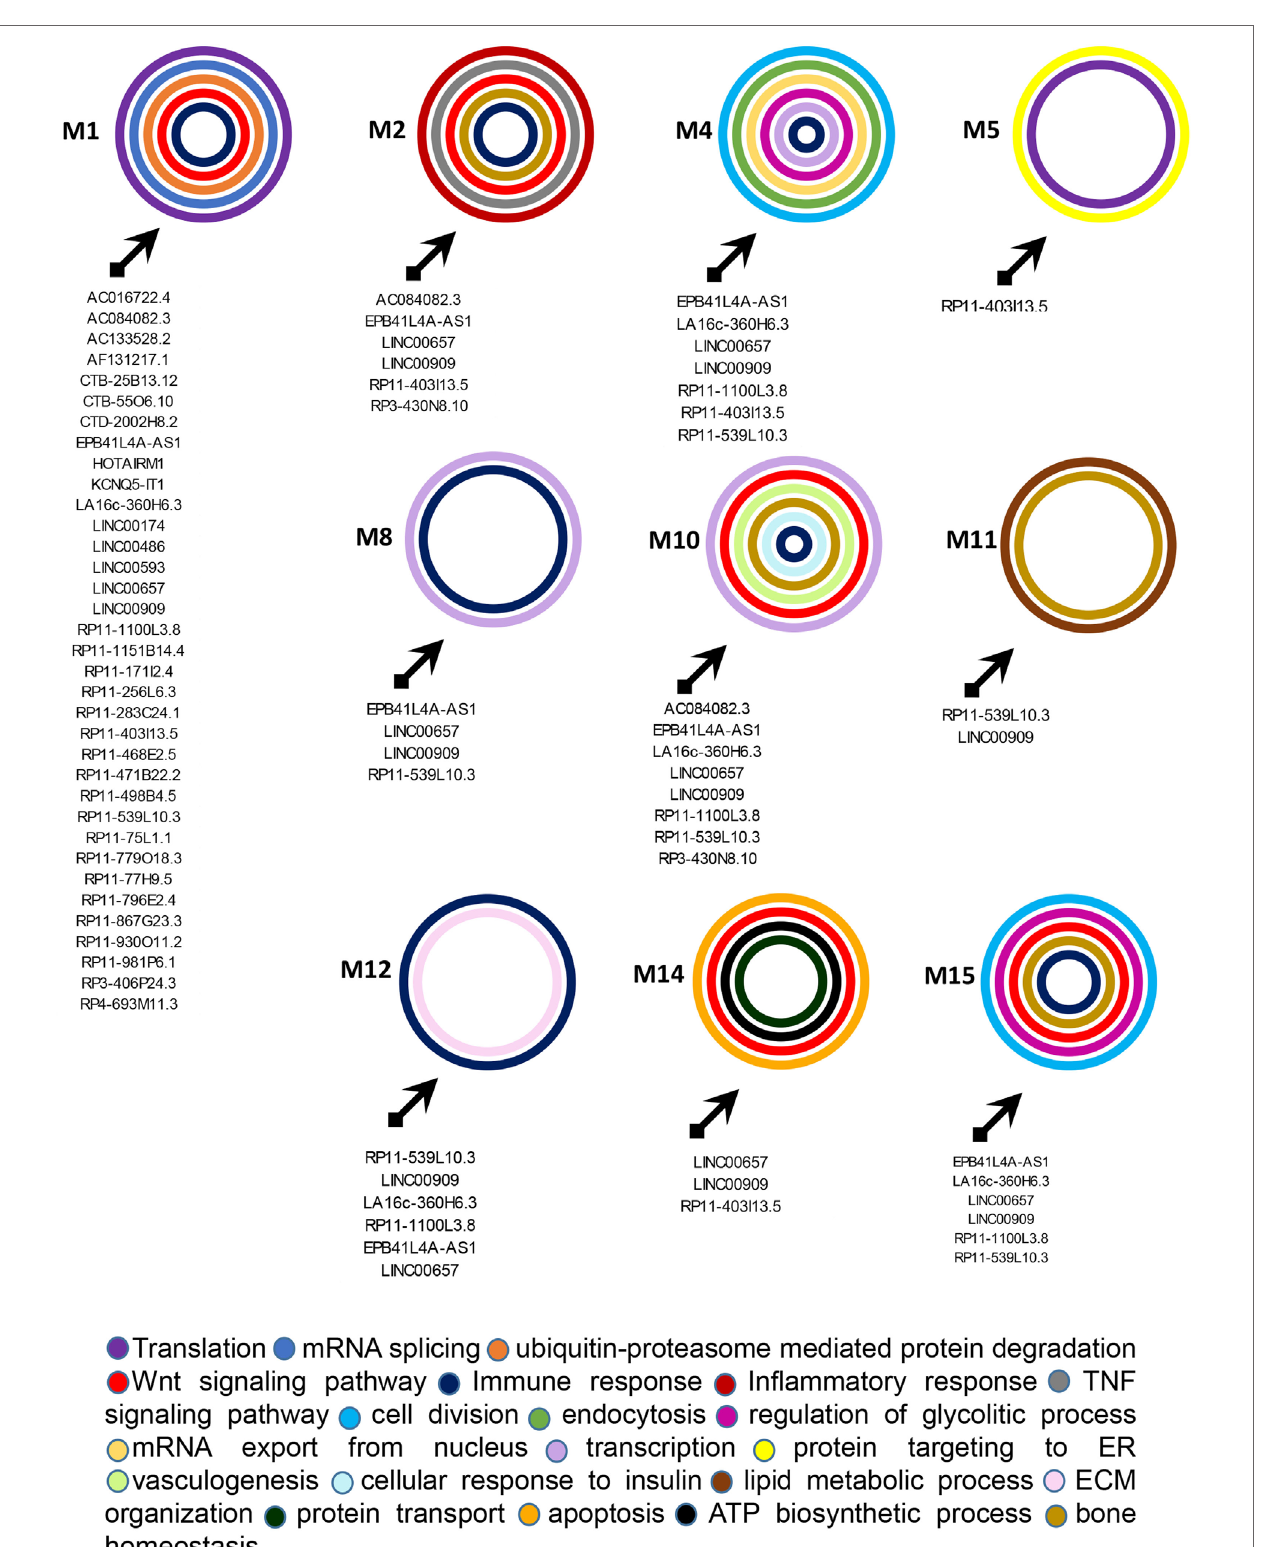
FigUre 5 | Functional classification of genes included in the targeted modules. Graphical representation of long non-coding RNAs targeting the gene modules and of the most relevant biological processes (BPs) in which genes in each module can be classified. The BPs are represented by colored circles (each color corresponds to a different BP). The size of circles does not correspond to the number of genes that are classified in each BP.